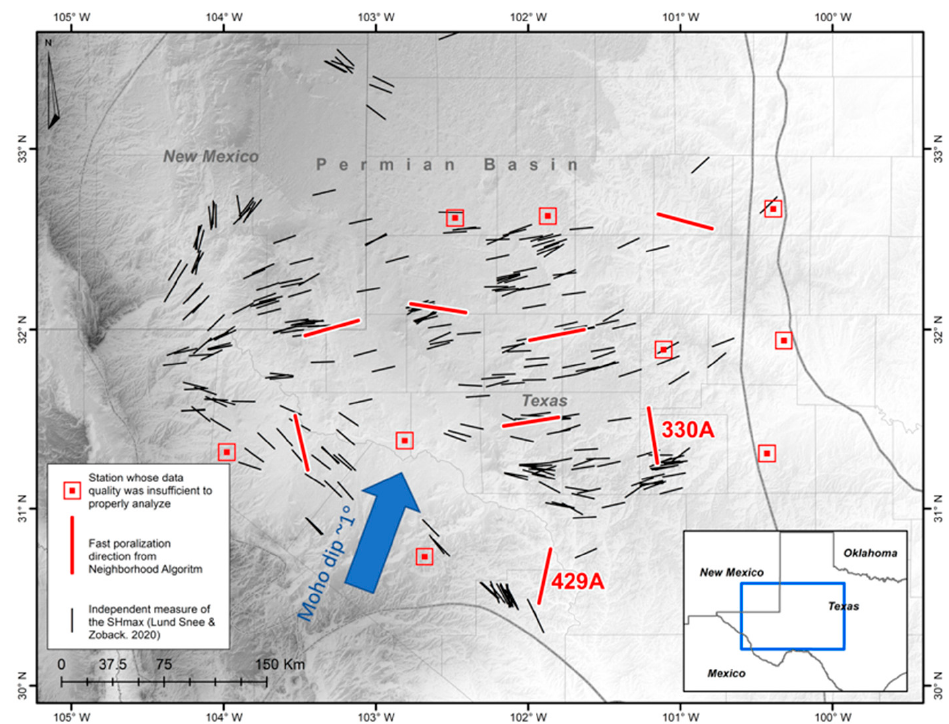
Figure 9. Map of the seven US Array stations analyzed in the Permian Basin Texas (red symbols), Moho dip direction and magnitude (inferred from [29]), and independent stress indicators (black symbols) [3]. The black outlines are the sedimentary basins. Most of the indicators are in the Permian Basin.